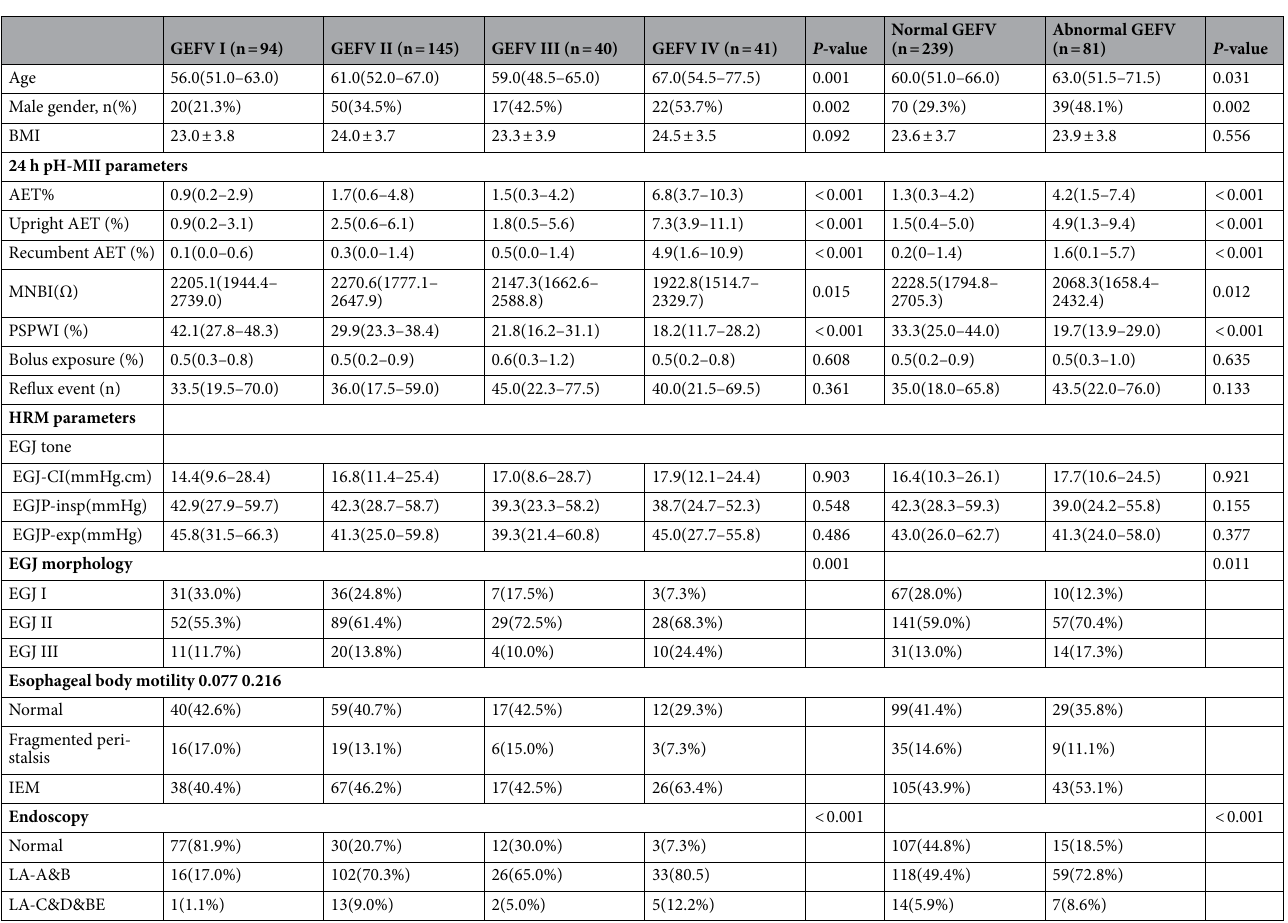
Table 2. Demographic and 24-h MII-pH Data and HRM Parameters of 320 Patients with GERD Symptoms according to GEFV Grade. Values are presented as the median and interquartile range, except for BMI (mean and standard deviation), male gender, EGJ morphology, Esophageal body motility, and Endoscopy (n and %). MII-pH multichannel intraluminal impedance-pH, HRM high-resolution manometry, GERD gastroesophageal reflux disease, GEFV gastroesophageal flap valve, BMI body mass index, BE Barrett’s esophagus, AET acid exposure time, MNBI mean nocturnal baseline impedance, PSPWI post-reflux swallow-induced peristaltic wave index, EGJ esophagogastric junction, EGJ-CI EGJ-contractile integral, EGJP-insp inspiratory EGJ pressure, EGJP-exp expiratory EGJ pressure, IEM ineffective esophageal motility. P < 0.05 was considered to